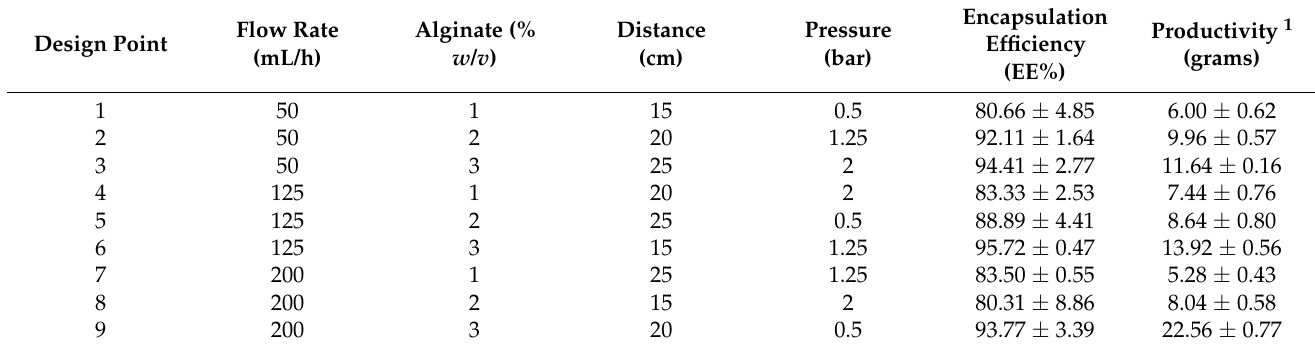
Table 2. Antigen encapsulation efficiency using the orthogonal matrix L9(3 4 ).